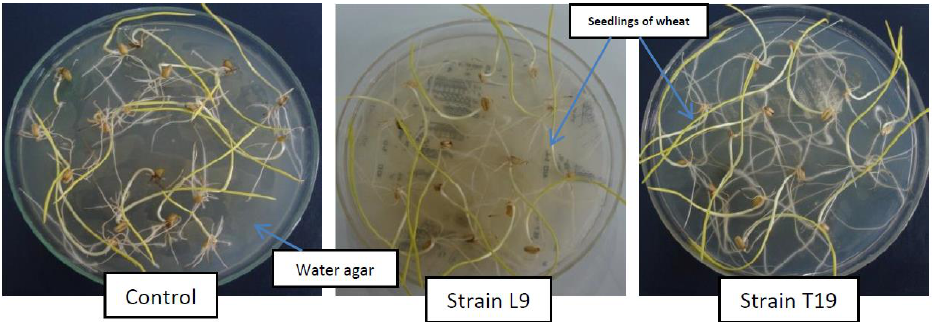
Figure 5. The pictorial view of seedlings of wheat growing on water agar in agar